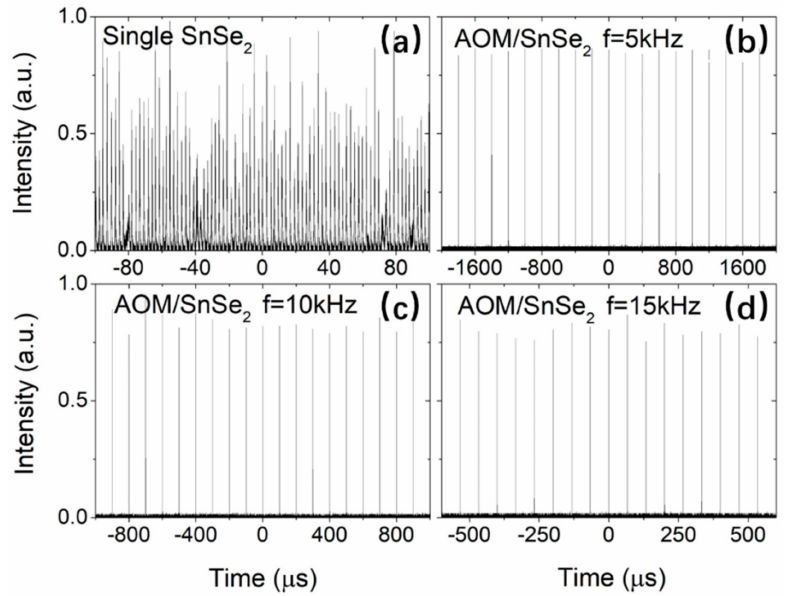
Figure 8. Oscilloscope shapes of the envelope sequences at 8.5 W pump power: ( a ) single SnSe 2 -SA QML; ( b ) SnSe 2 /AOM APDM QML with f = 5 kHz; ( c ) SnSe 2 /AOM APDM QML with f = 10 kHz; ( d ) SnSe 2 /AOM APDM QML with f = 15